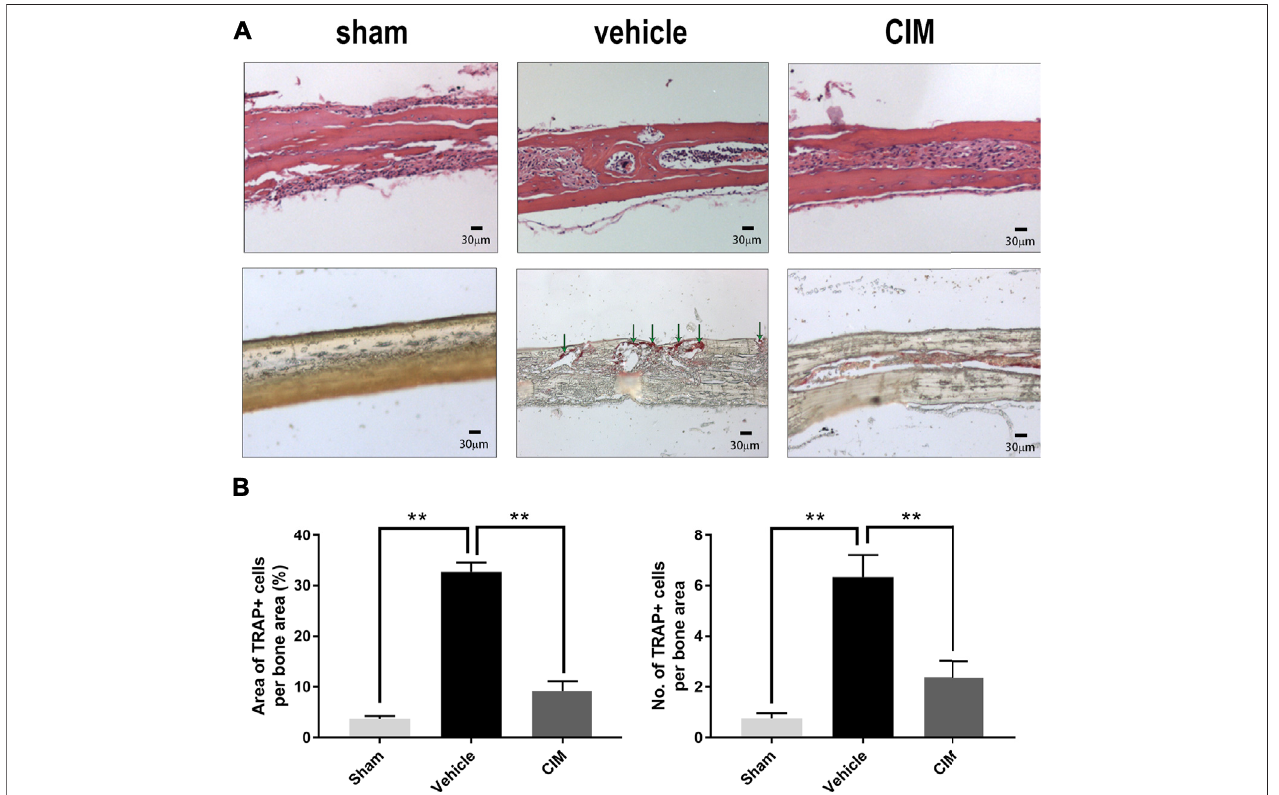
FIGURE6| Histologicalstainingshowinginhibitedboneerosionandosteoclastaccumulationintheharvestedmurinecalvaria. (A) RepresentativeimagesofHand E and TRAP staining ( × 100) in the indicated groups (the green arrows refer to the area of TRAP + cells). (B) Diagram and statistical analysis of the area and number of TRAP + cells per bone region. (**: p < 0.01 versus the control